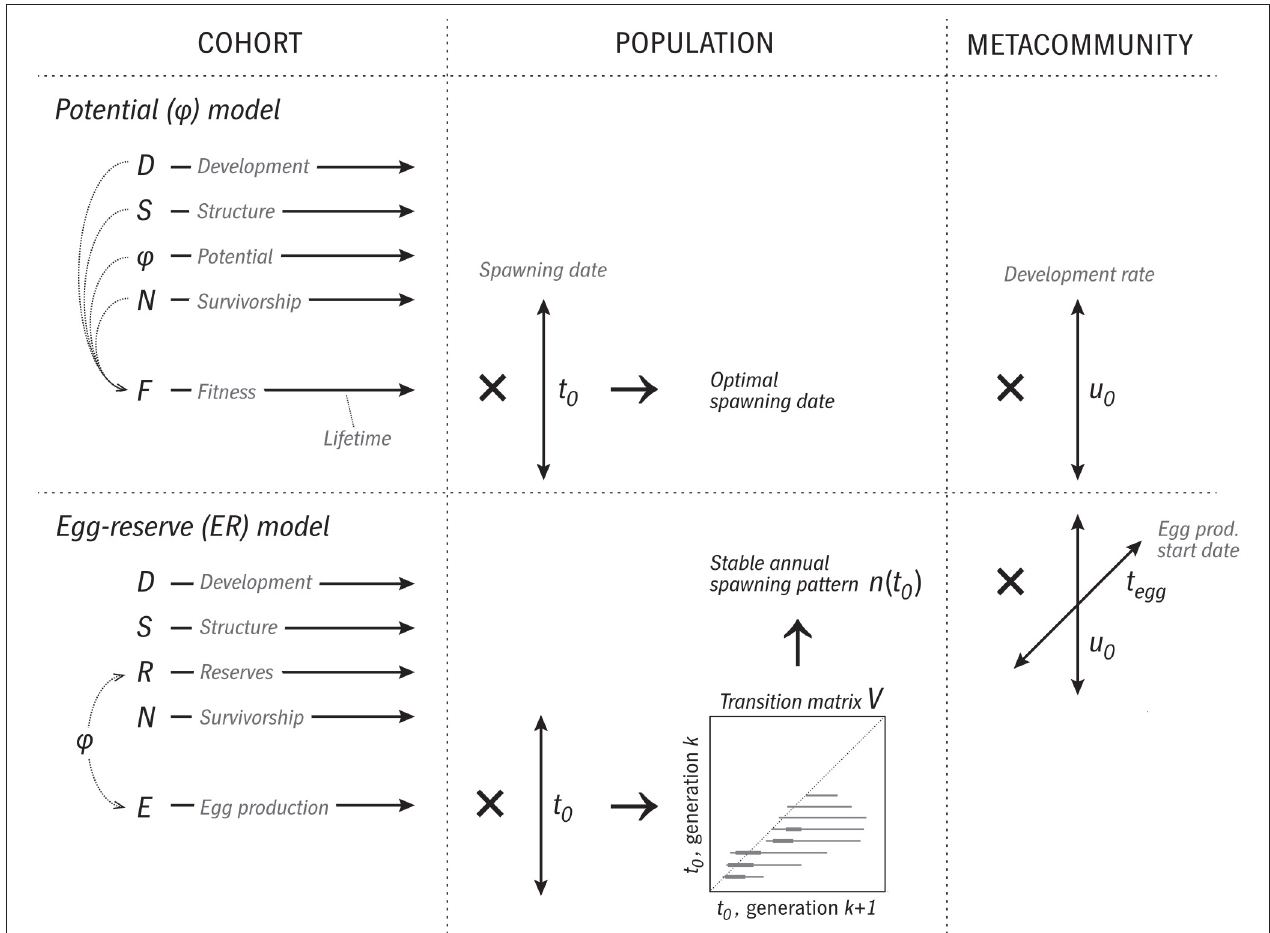
FIGURE 2 | Overview of the logic and execution of the two versions of the Coltrane 1.0 model. In the ϕ version, a cohort is represented by four state variables ( D , S , ϕ , N ) integrated forward in time over the cohort’s lifespan. These are used to calculate a time series of fitness F . Next, this calculation is repeated across a family of spawning dates t 0 , and optimal and viable t 0 cases determined. This constitutes a population-level description, which then can be repeated across a range of trait values ( u 0 , relative development rate) to describe a size-variable metacommunity. In the ER version, at the cohort level, ϕ is replaced by the state variable R and a time series of egg production E . Across a family of t 0 cases, a transition-matrix method is used to determine a stable annual pattern of relative egg production n ( t 0 ), which is taken as the population-level prediction. A metacommunity is formed by varying two traits, u 0 and the date at which egg production begins t egg